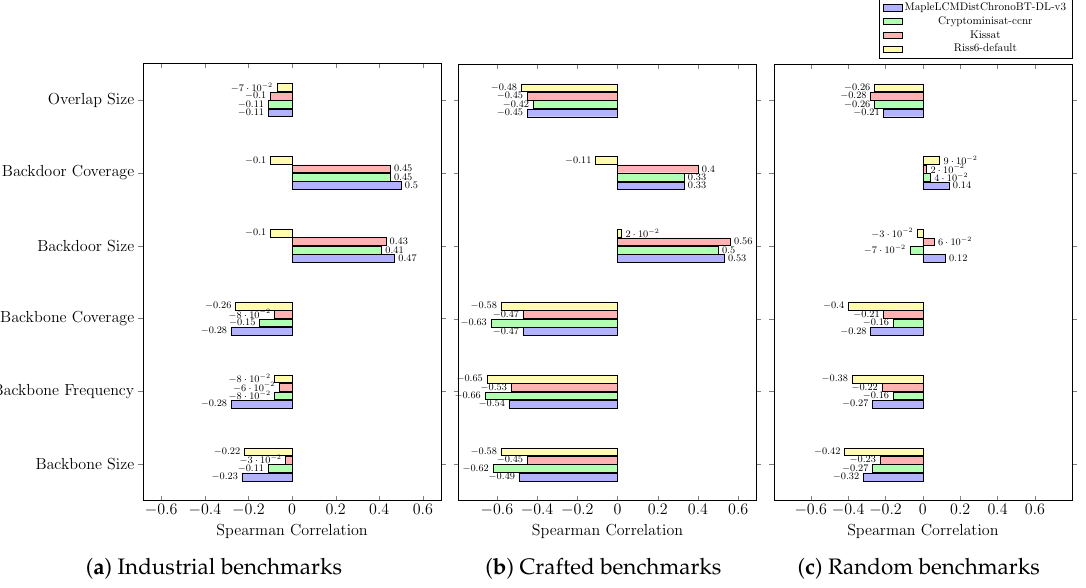
Figure A5. Spearman correlation results between Boolean structural measures and the number of decisions on 2002–2020 SAT benchmark